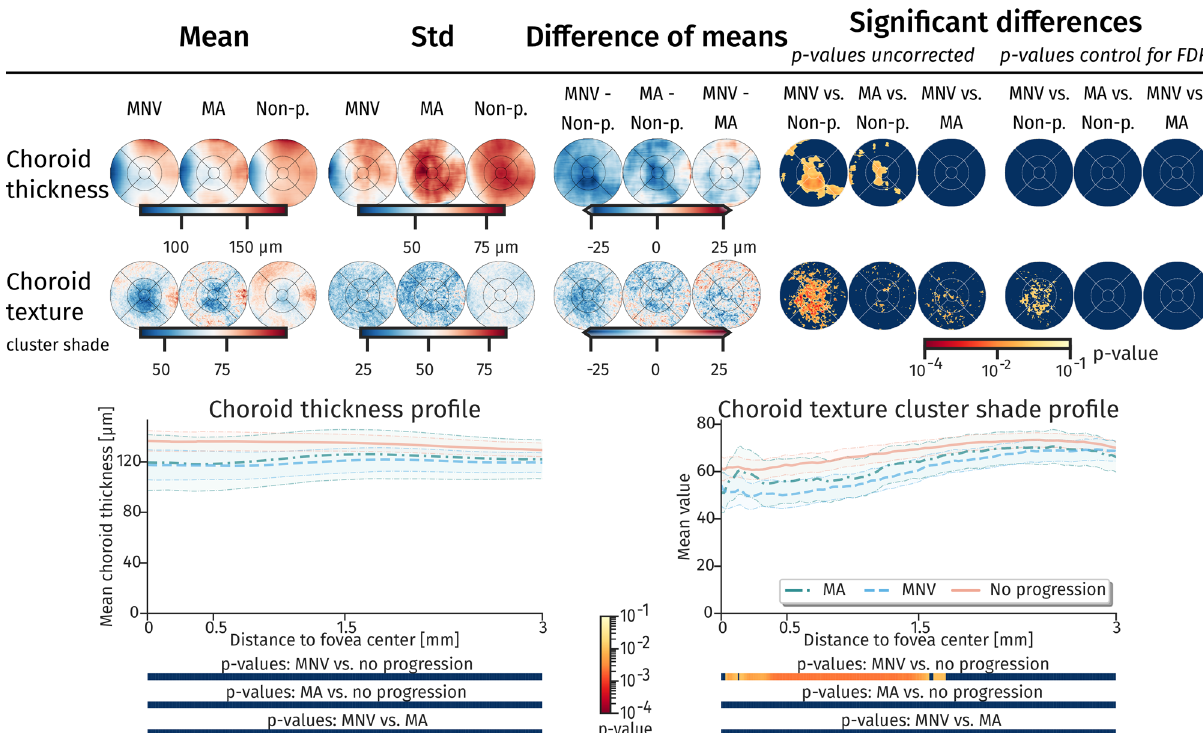
Figure 6. Topographic maps and profiles of choroidal thickness and texture. Spatial distribution (top) and topographic profile (bottom) of choroidal thickness and choroidal texture property (cluster shade), which shows significant differences between groups macular neovascularization (MNV), macular atrophy (MA) and non- progressor (Non-p). Confidence interval and p-value properties are identical to Figs. 3 and